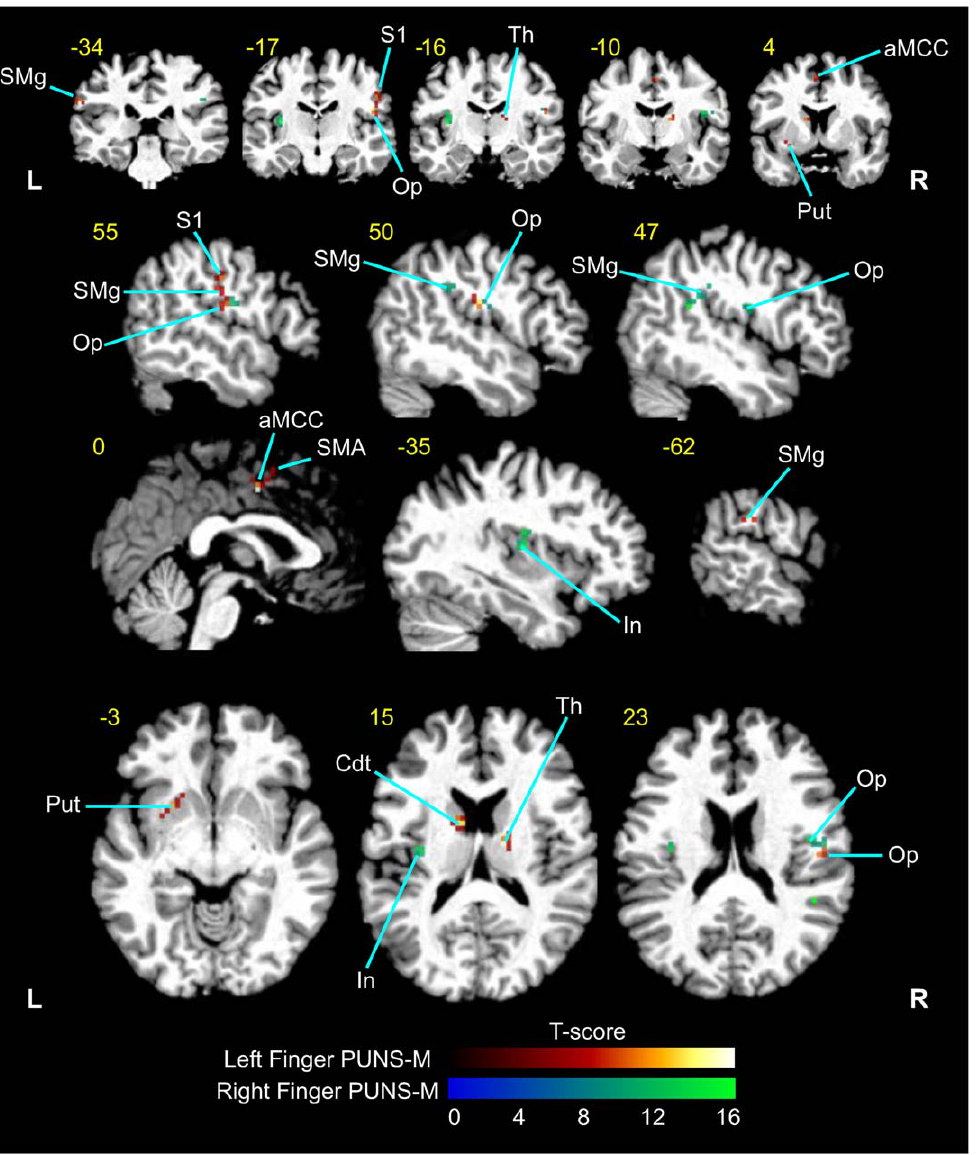
Figure 4. PUNS-M stimulates BOLD contrast signals in somatosensory detection and discrimination networks. Grand average fMRI BOLD responses obtained from five subjects in response to left finger ( red-yellow LUT) and right finger ( blue - green LUT) stimulation with PUNS-M waveforms (L = Left, R = right). Anatomical areas shown were significantly activated (p , 0.001). The yellow numbers correspond to MNI slices in respective views while white labels indicate anatomical regions abbreviated as follows: SMg = supramarginal gyrus; S1 = primary somatosensory cortex; Op = parietal operculum; Th = thalamus; aMCC = anterior middle cingulate cortex; Put = putamen; SMA = supplementary motor area; In = Insula; Cdt =